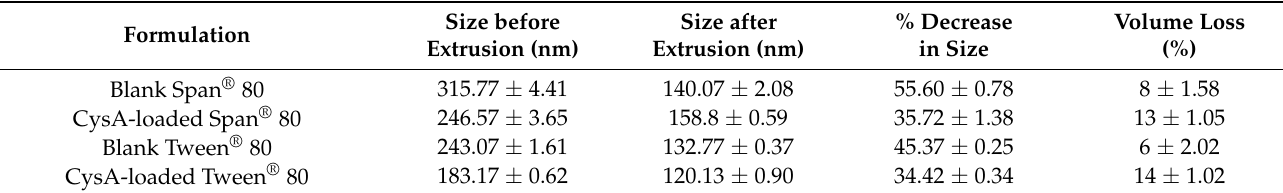
Table 5. Flexibility analysis of